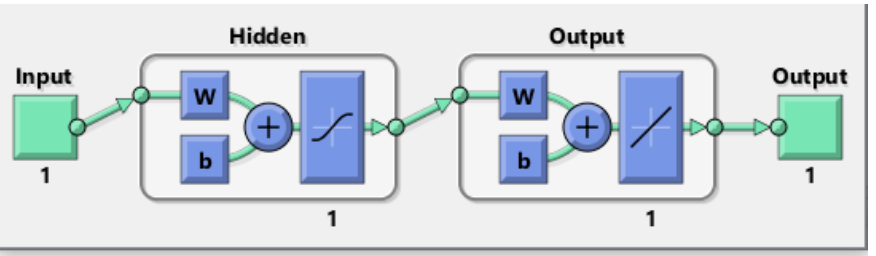
Figure 7. Diagram of the ANN model for HTP, where w represents the ANN weights and b represents bias; Input is the fabric property thickness and Output is HTP.